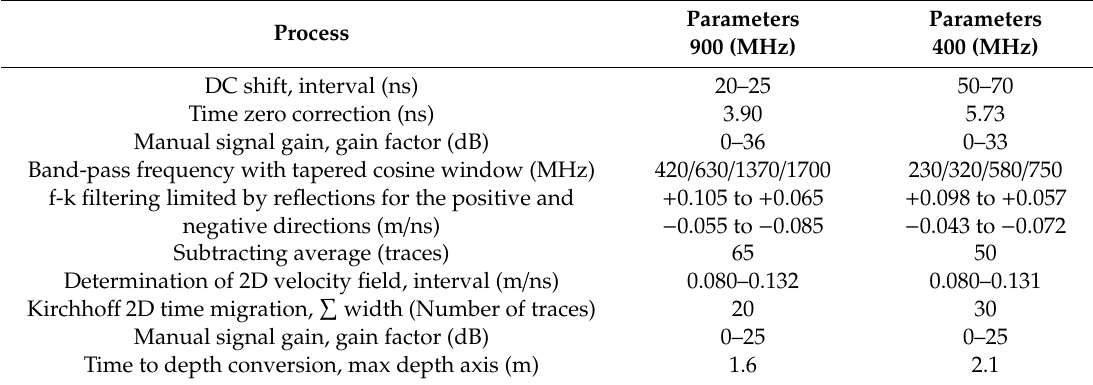
Table 2. The procedures and the parameters used in the proposed model of GPR dependent on the central frequency of the